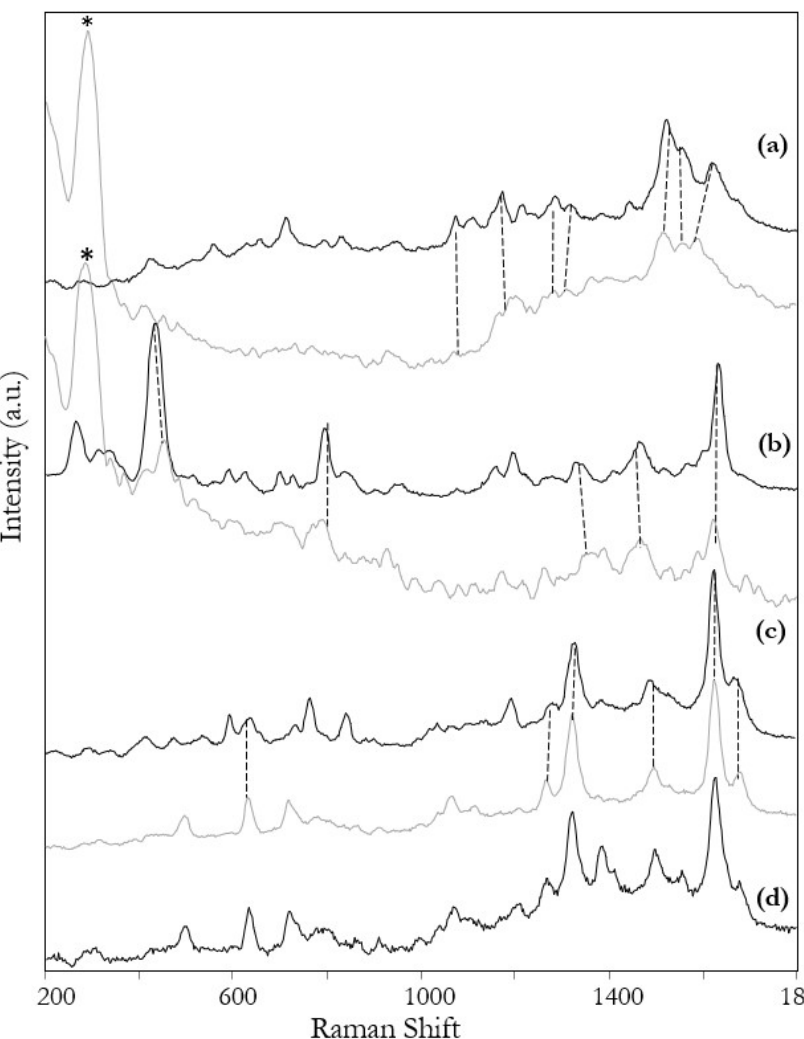
Figure 4. SERS spectra of ( a ) yellow, ( b ) cyan, ( c ) magenta dyes extracted after TLC separation (grey line) in comparison with those of the synthesised reference colourants (black line) and ( d ) SERS spectrum of the overall extract from the motion picture film. * = signal due to silver colloid.